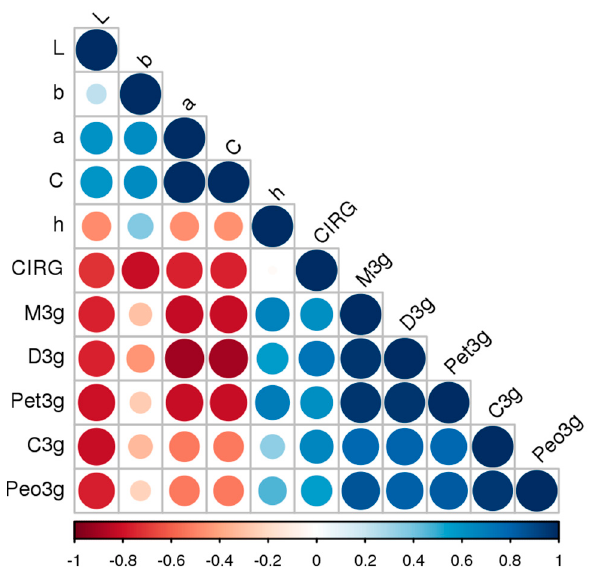
Figure 1. Visualization of Pearson correlation coefficients of CIELab color variables (L*—Lightness, a*—red / green, b*—yellow / blue, C*—chroma, h ◦ —hue angle, CIRG—color index for red grapes), and concentrations of individual anthocyanins (3- O -monoglucosides of M3g—malvidin, D3g—delphinidin, C3g—cyanidin, Pet3g—petunidin, Peo3g—peonidin).